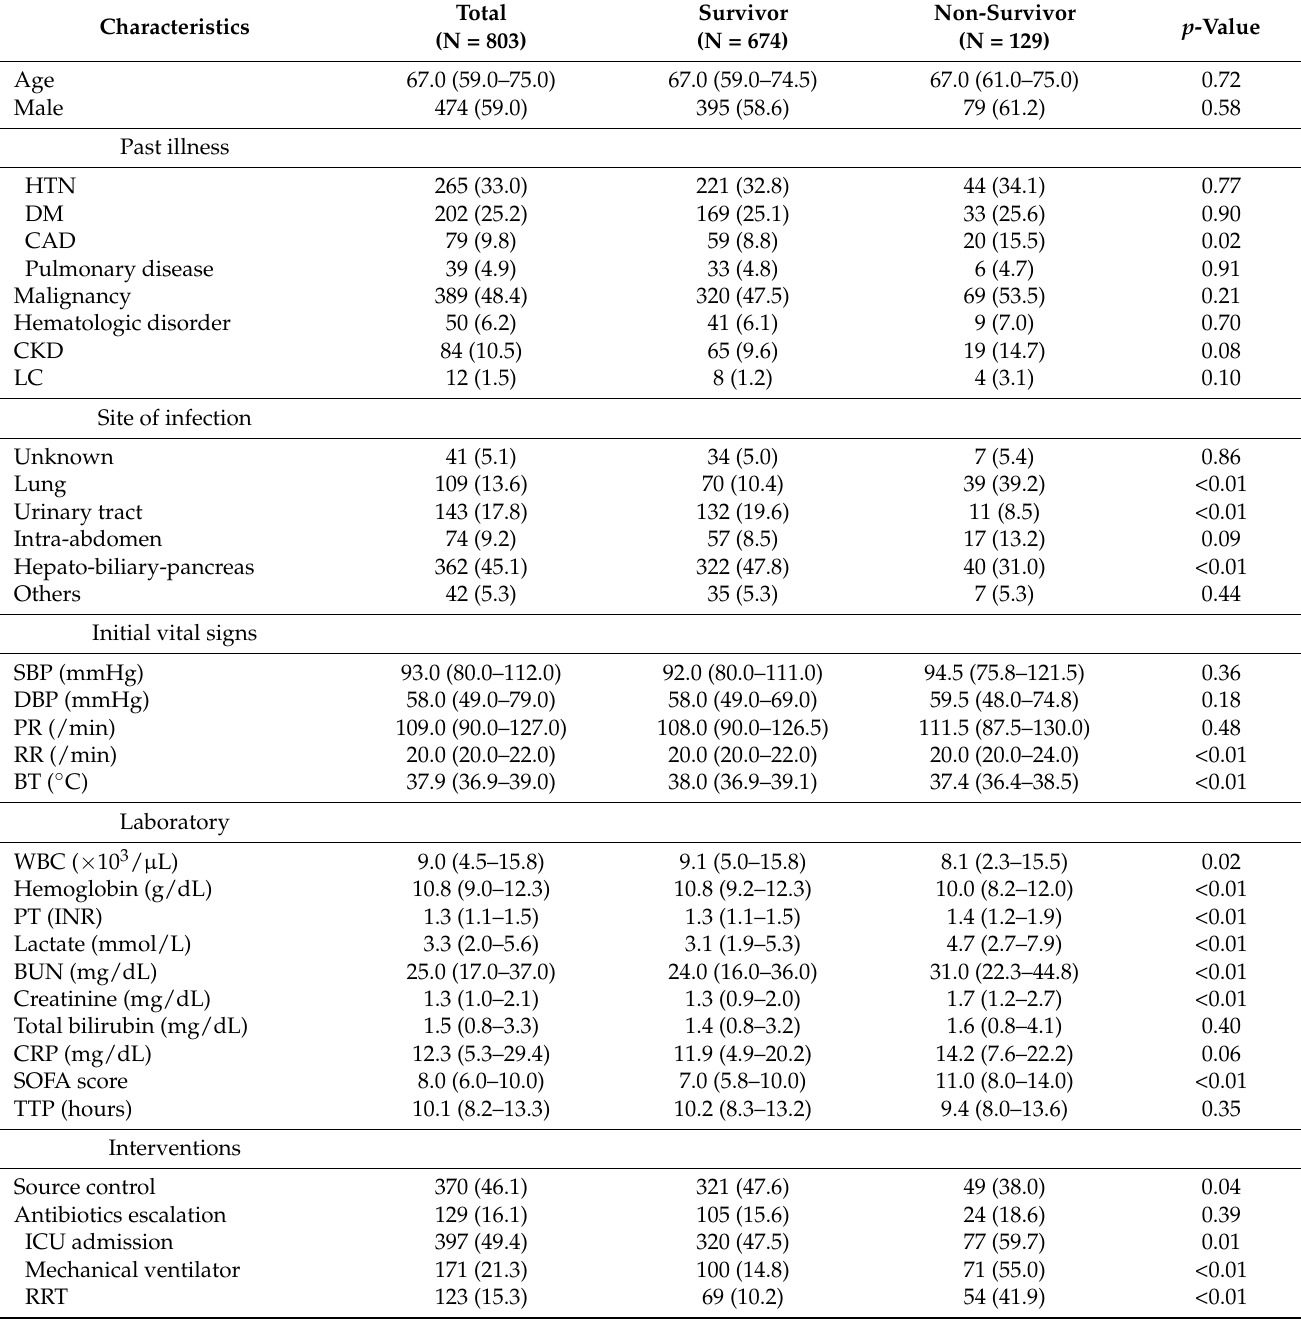
Table 1. Baseline characteristics of septic shock patients according to the blood culture